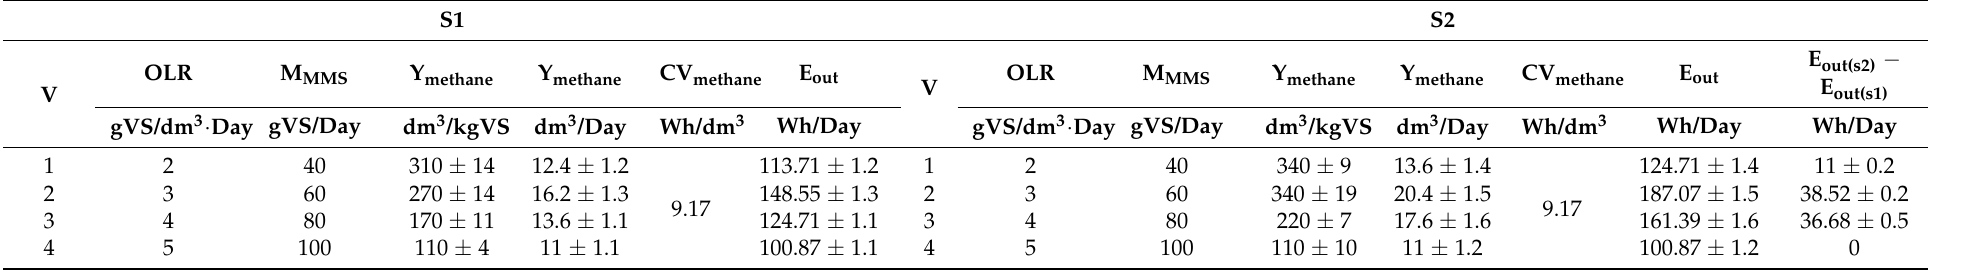
Table 4. Estimated energy production depending on the experimental